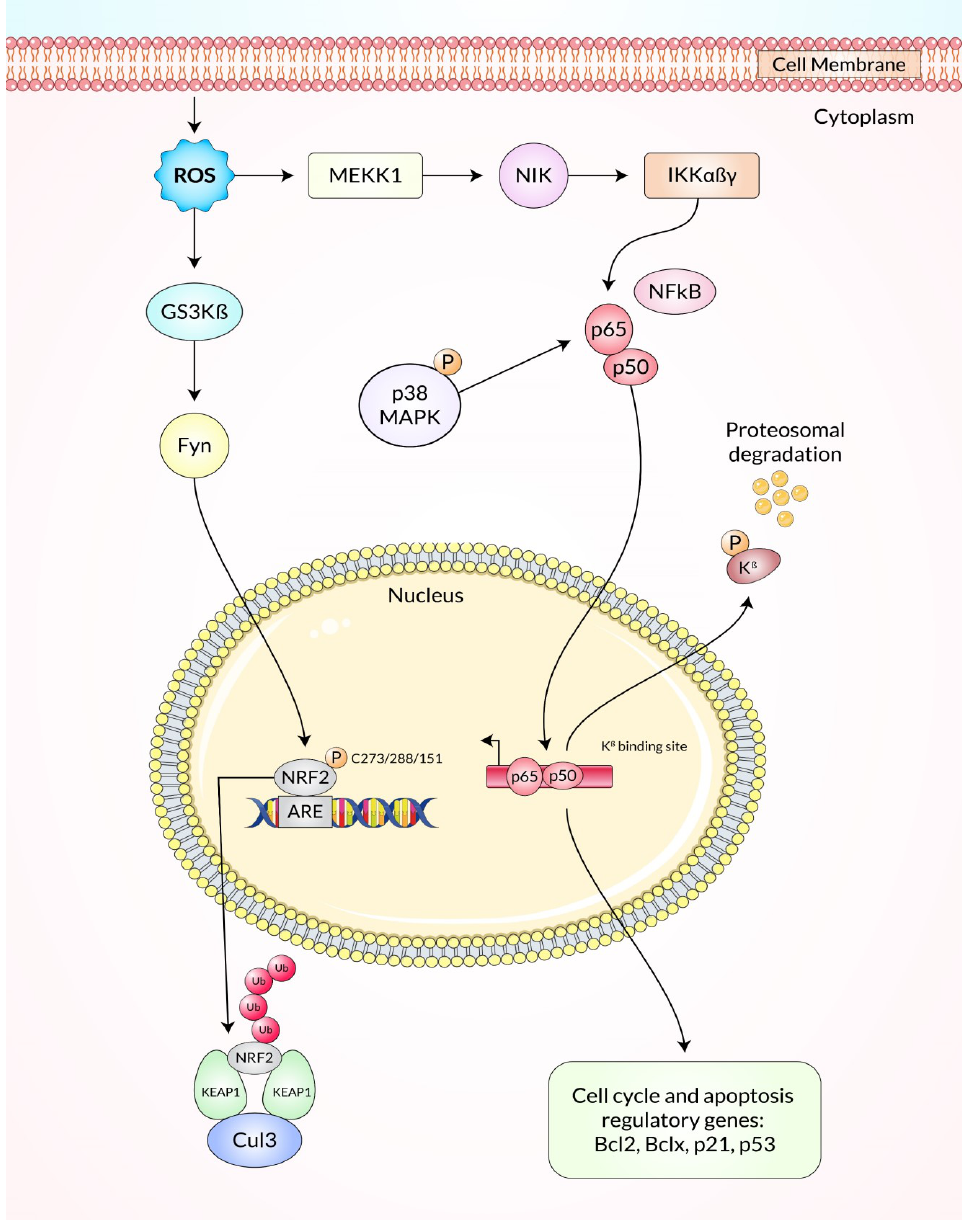
Figure 3. Intracellular cell signaling pathways mediated by ROS.